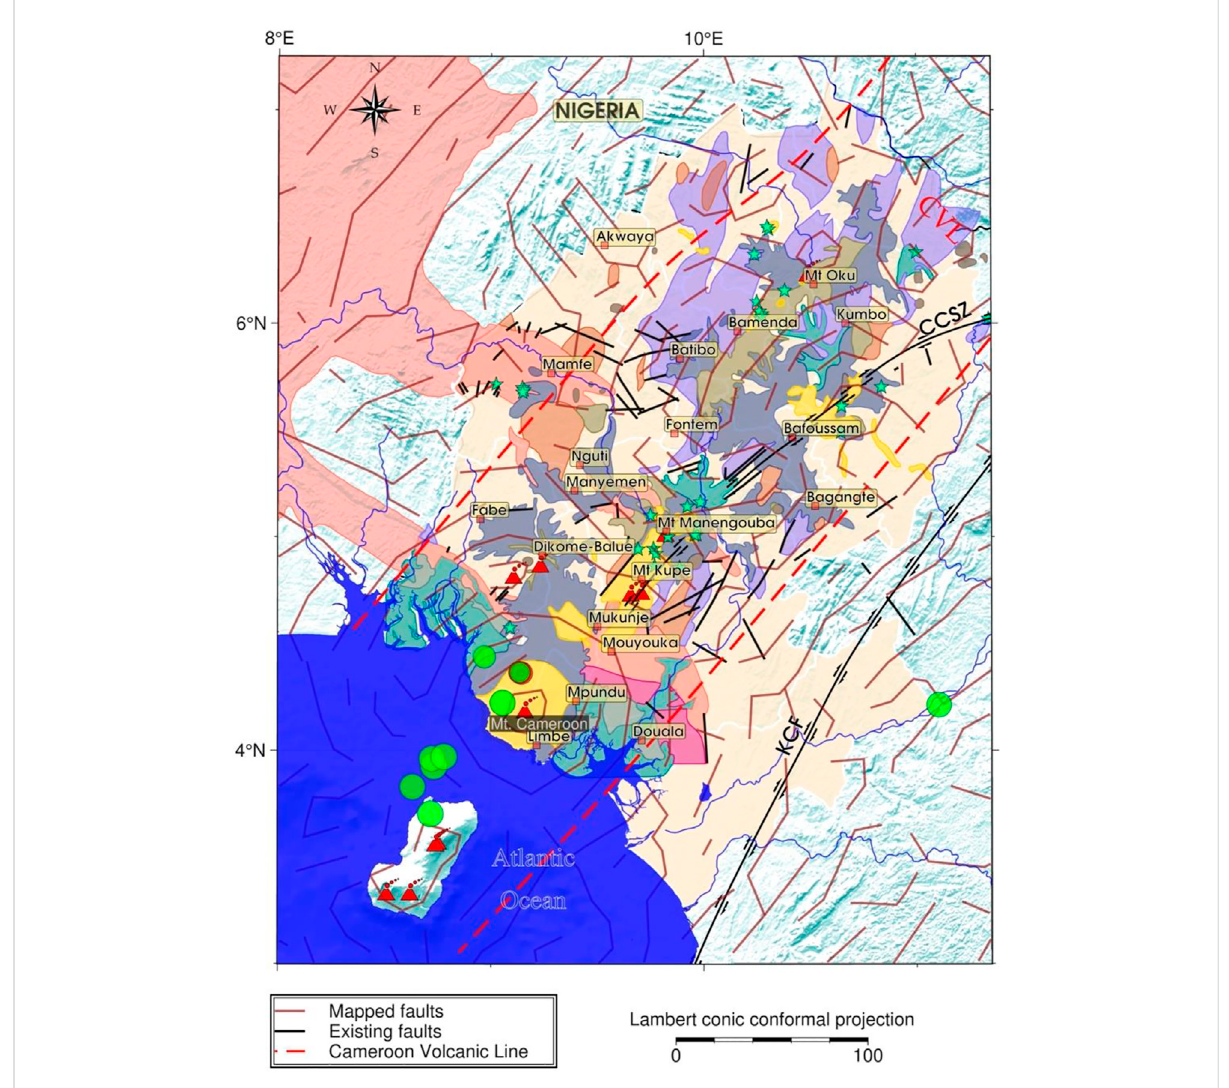
FIGURE 11 Representation of new faults compared to the existing ones. Legend and abbreviations as shown in Figure